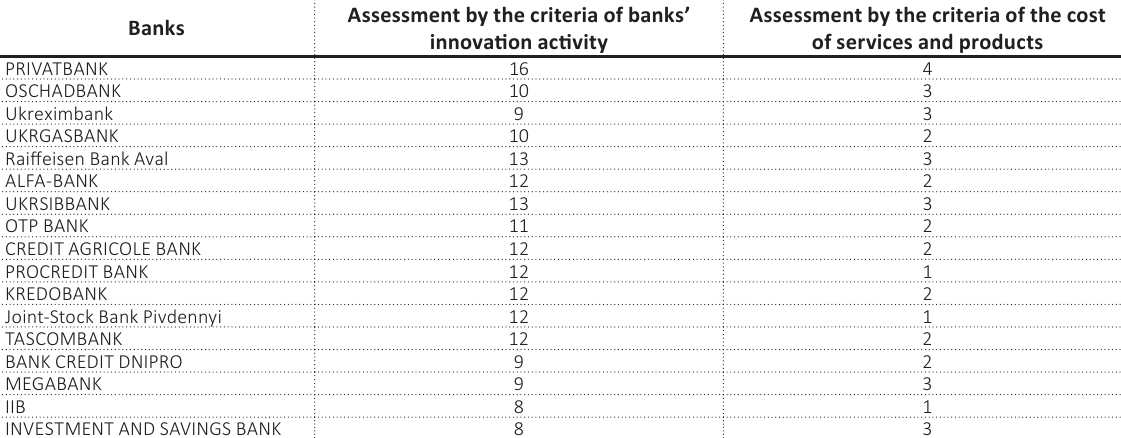
Table 2. Comparison of Ukrainian banks as partners of enterprises in terms of innovation activity